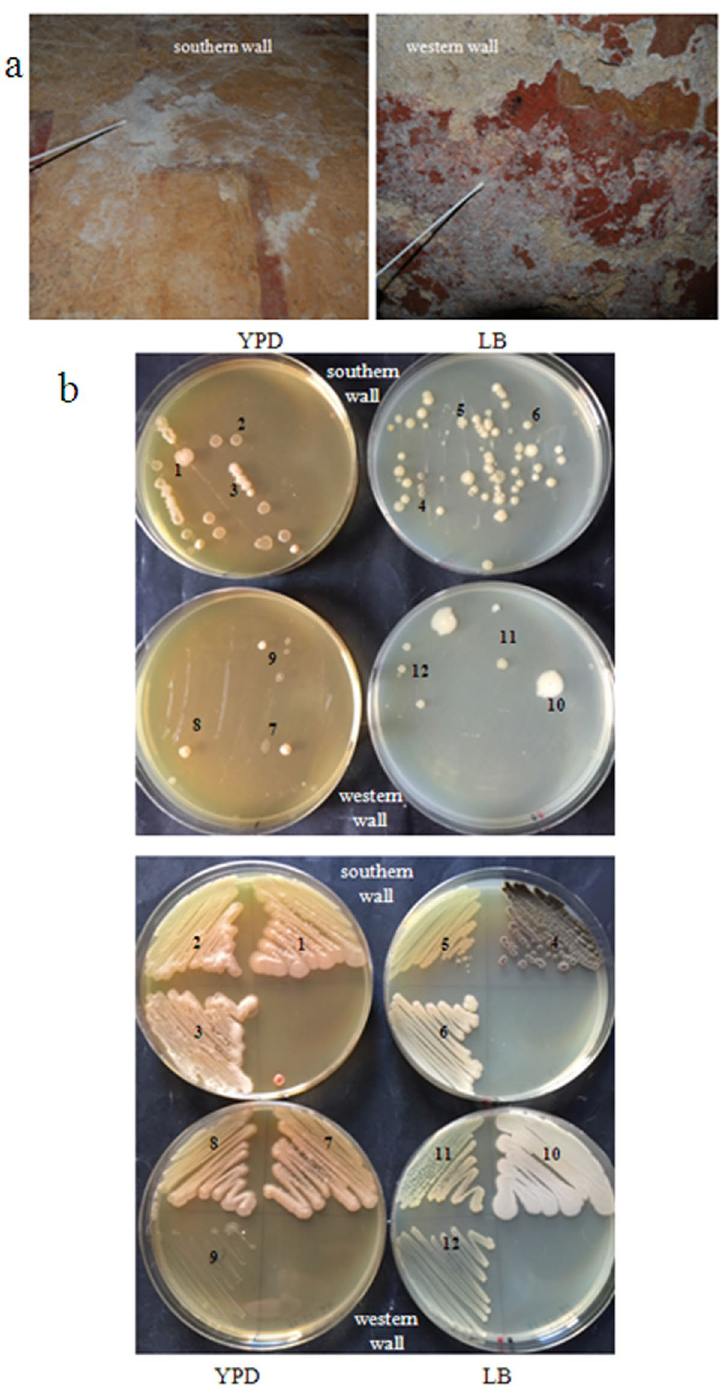
Figure 2. Microorganisms isolated from the walls. ( a ) Samples from southern and western walls were taken with two sterile swabs and ( b ) streaked in YPD and LB plates. ( c ) After colony morphology and microscopic observations, 12 pure cultures were chosen for further